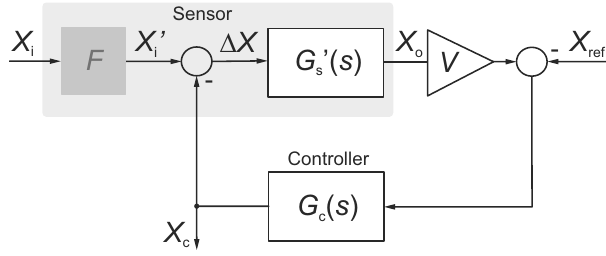
Figure 11. Closed-loop compensation circuit where the sensor out- put signal X o is fed back to the sensor input via an amplifier and a controller. F is a transfer element transforming an arbitrary input quantity in a quantity which can be actually